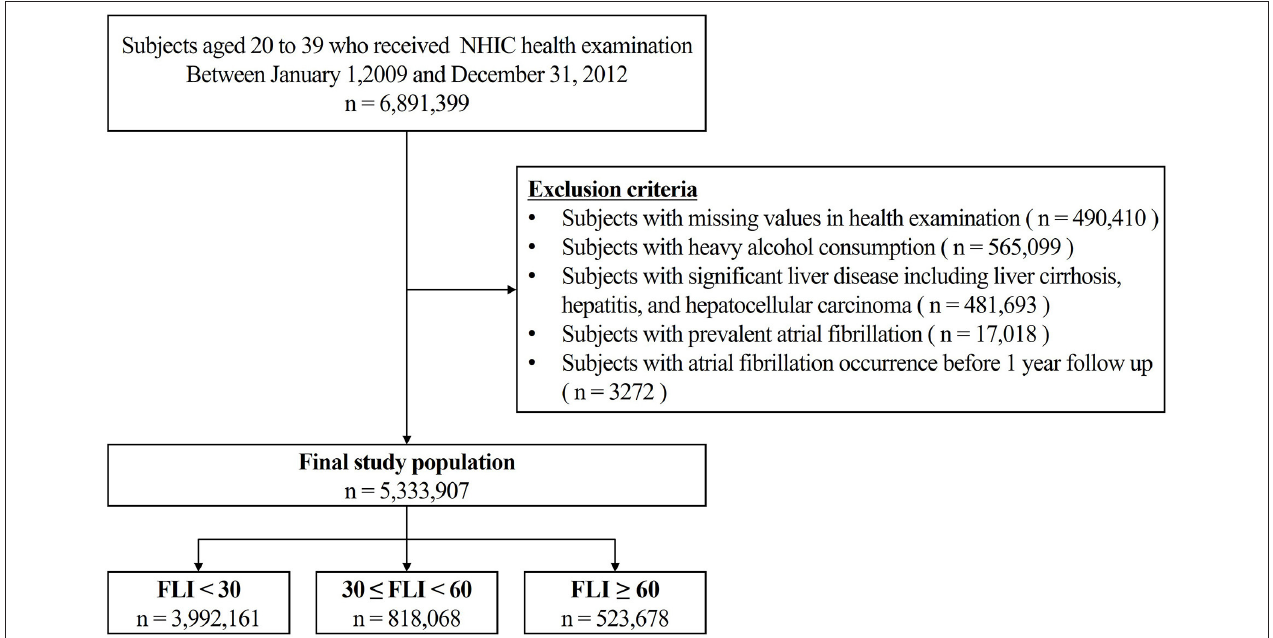
FIGURE 1 | Overview of the Patient flow. NIHC, National health insurance corporation; FLI, fatty liver index.